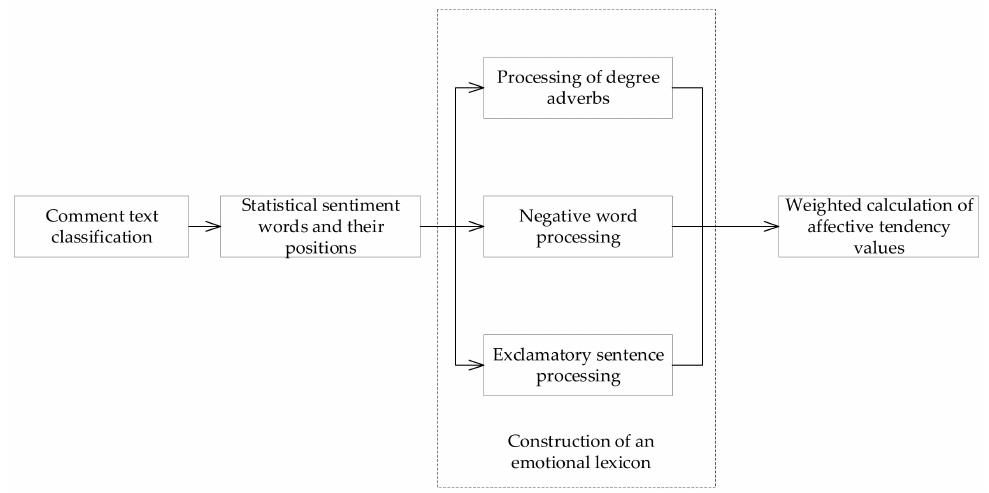
Figure 3. Emotional